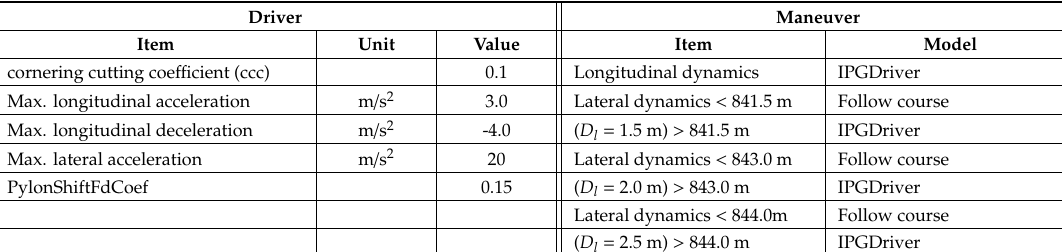
Table 4. Driver maneuvers were set to avoid feint motions.